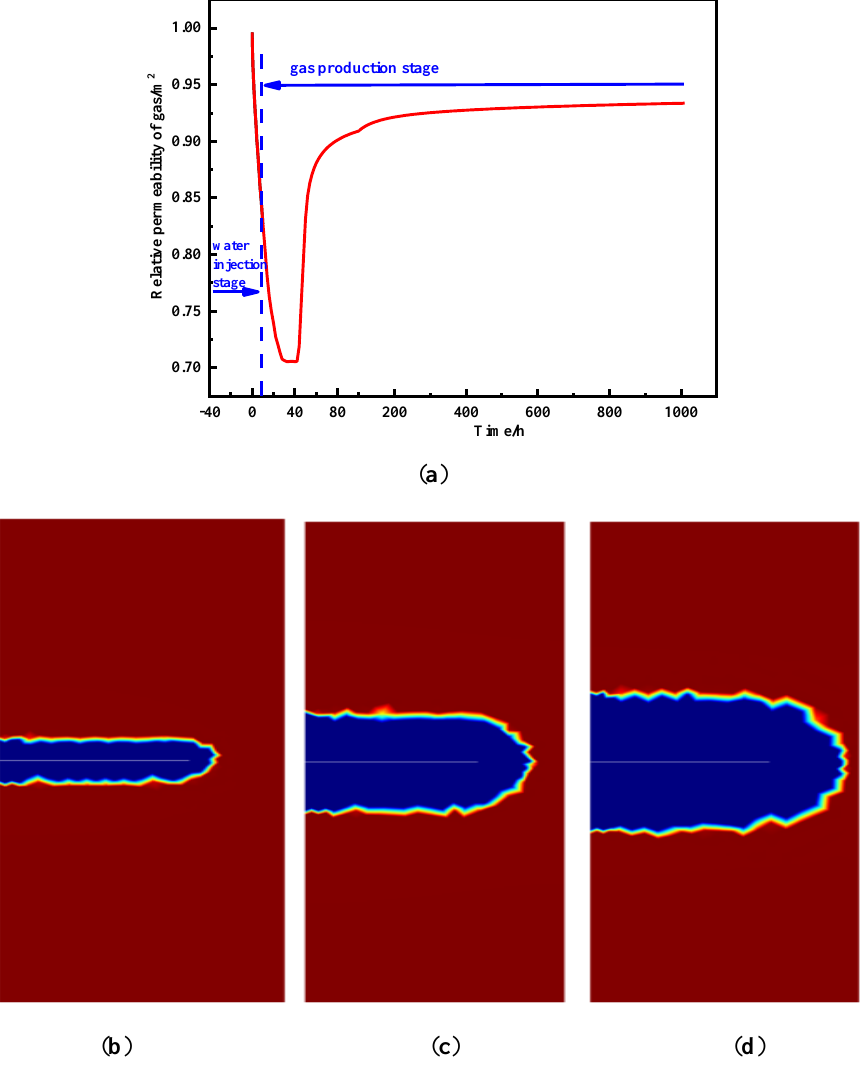
Figure 7. Variation of the relative permeability of the gas phase with time ( a ), Gas-phase saturation distribution at the water injection stage t = 1 h ( b ), 5 h ( c ), and 10 h ( d ). Two points were selected to illustrate the variations of gas relative permeability evolution with the point A is in the water saturation area and Point B is out of the water saturation area shown in Figure 3. As Shown in Figure 8, the saturation sum of the water phase and the gas phase is equal to 1. The initial state assumes that the water saturation of the system is 0, and the saturation of point A starts to increase at 2 h and quickly reaches fully saturation state. At the same time, the gas phase saturation of point A decreases rapidly from the initial value of 1. Since point B is far away from the main fracture, its water saturation remains at 0 at the end of water injection, which is exactly consistent with Figure 7d. This characteristic also demonstrates that at the end of water injection process, a large amount of area without water infiltration